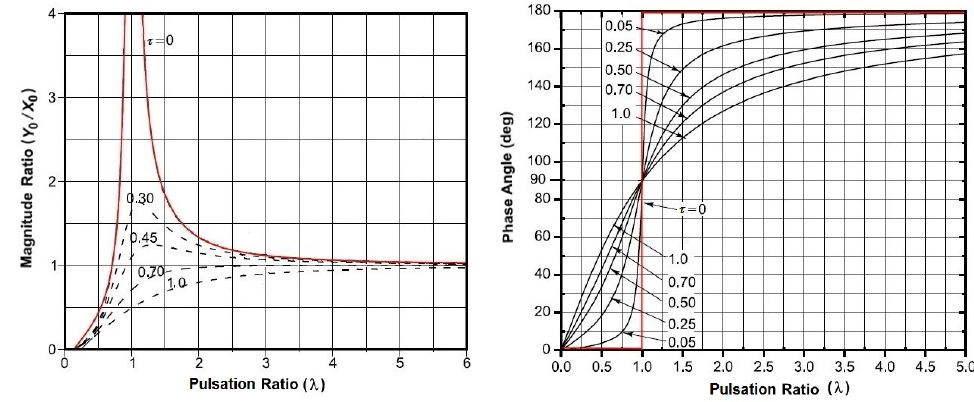
Figure 3. Magnitude ratio and phase of the response of a typical mass-spring-damper as a function of λ .